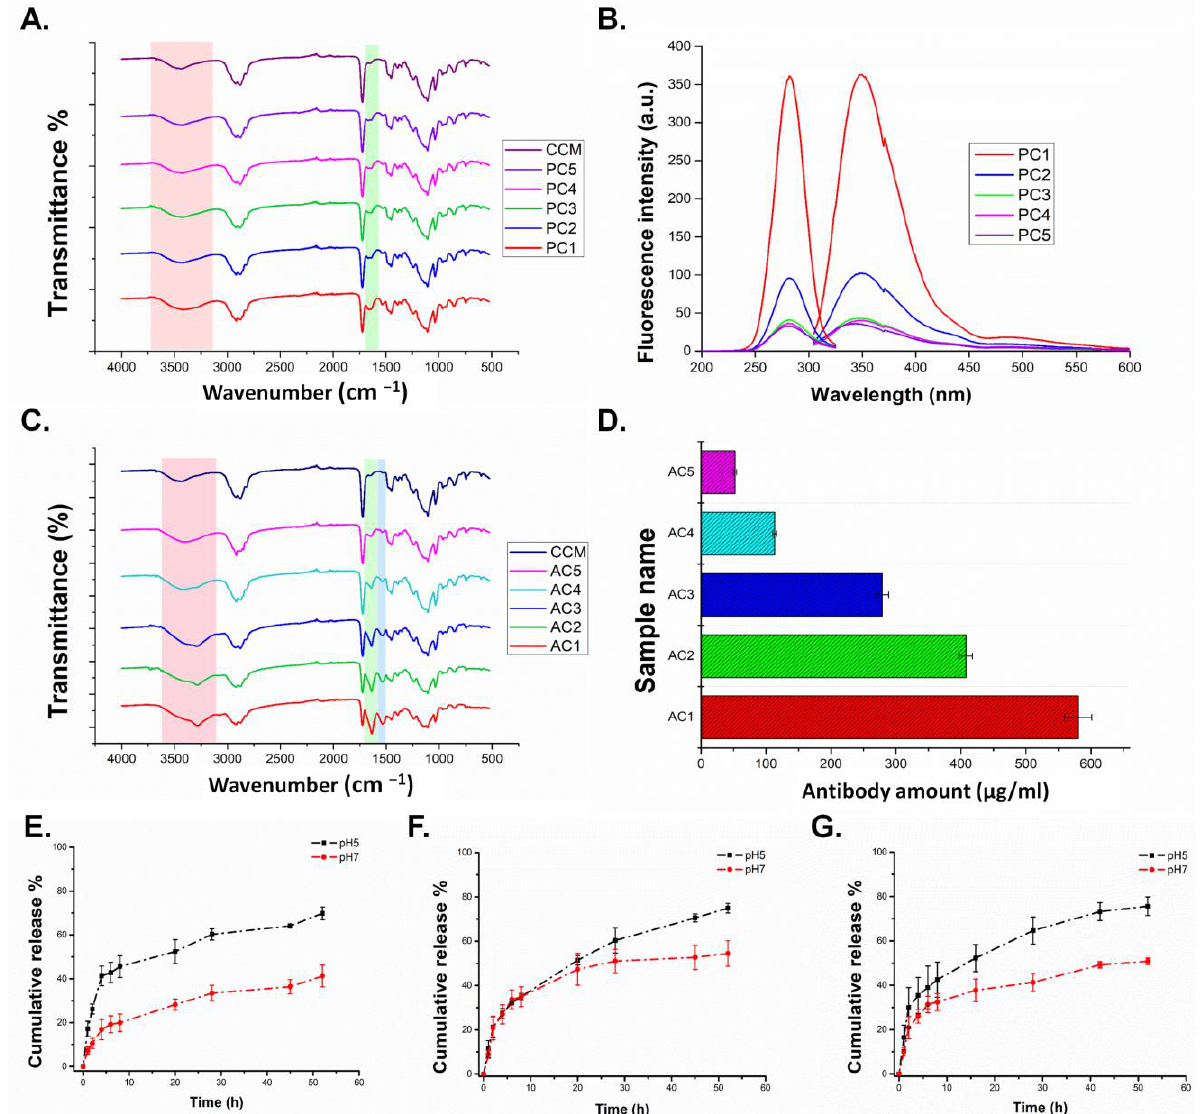
Figure 3. ( A ) FTIR spectra of PC1-5 and CCMS. ( B ) Excitation and emission spectrum of peptide conjugated PCs. ( C ) FTIR spectrum of AC1-5 and CCMS. ( D ) Antibody amount of ACs. ( E ) Release graph of micelles. ( F ) Peptide conjugated micelles. ( G ) Antibody conjugated micelles.